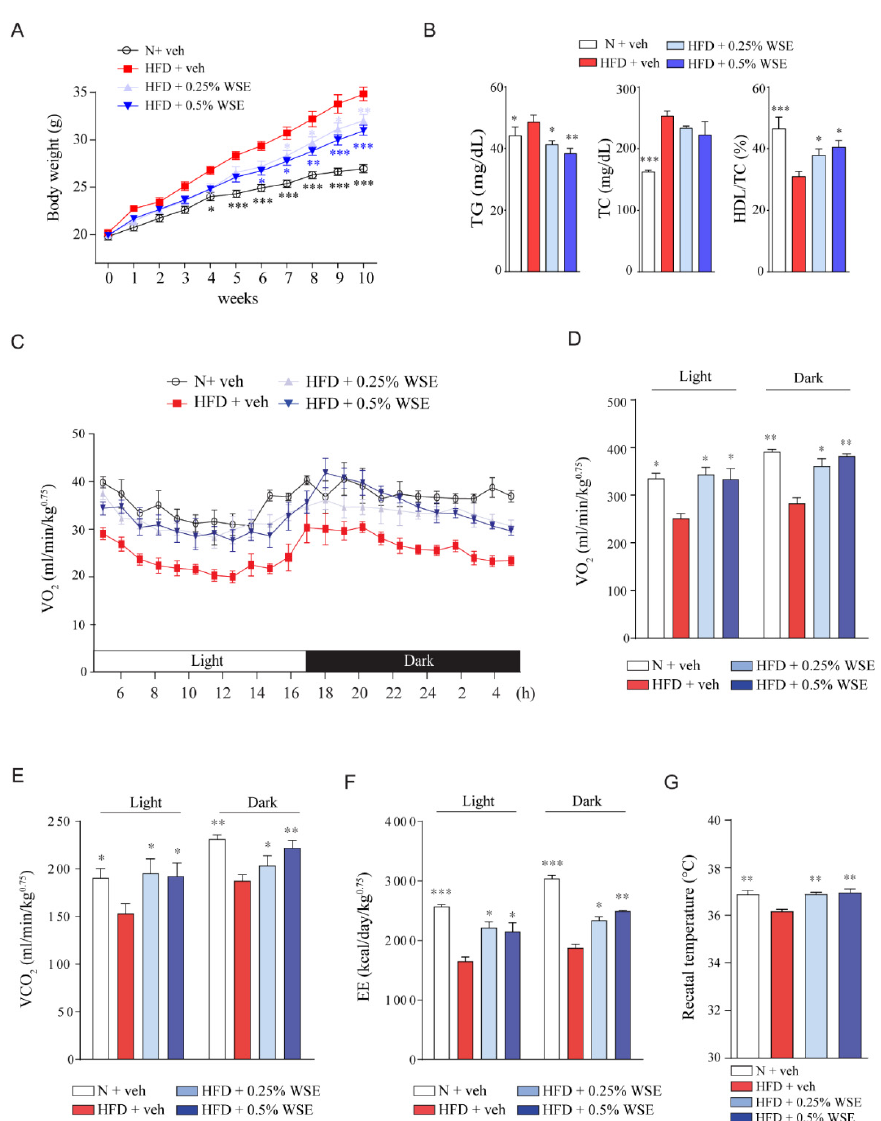
Figure 1. WSE prevents obesity by enhancing the oxygen consumption rate (OCR) in mice fed an HFD (high-fat diet). ( A ) Effect of WSE on mouse body weight during the 10 weeks experimental period. ( B ) Serum lipid levels. ( C ) VO 2 levels throughout the light/dark cycle were analyzed by indirect calorimetry. The levels were normalized to body weight. ( D ) Area under the curve (AUC) of VO 2 . AUC was calculated using Prism software ( Δ X*(Y1 + Y2)/2, X: Value of X axis, Y: Value of Y axis). ( E ) AUC of VCO 2 . ( F ) Energy expenditure was calculated based on the VO 2 and VCO 2 levels. ( G ) Rectal temperature was measured at room temperature. Data represent the mean ± SEM ( n = 5). Difference between groups was evaluated by Tukey’s multiple comparison test. * p < 0.05; ** p < 0.01; *** p < 0.001 compared with the HFD group. N: Normal control diet.